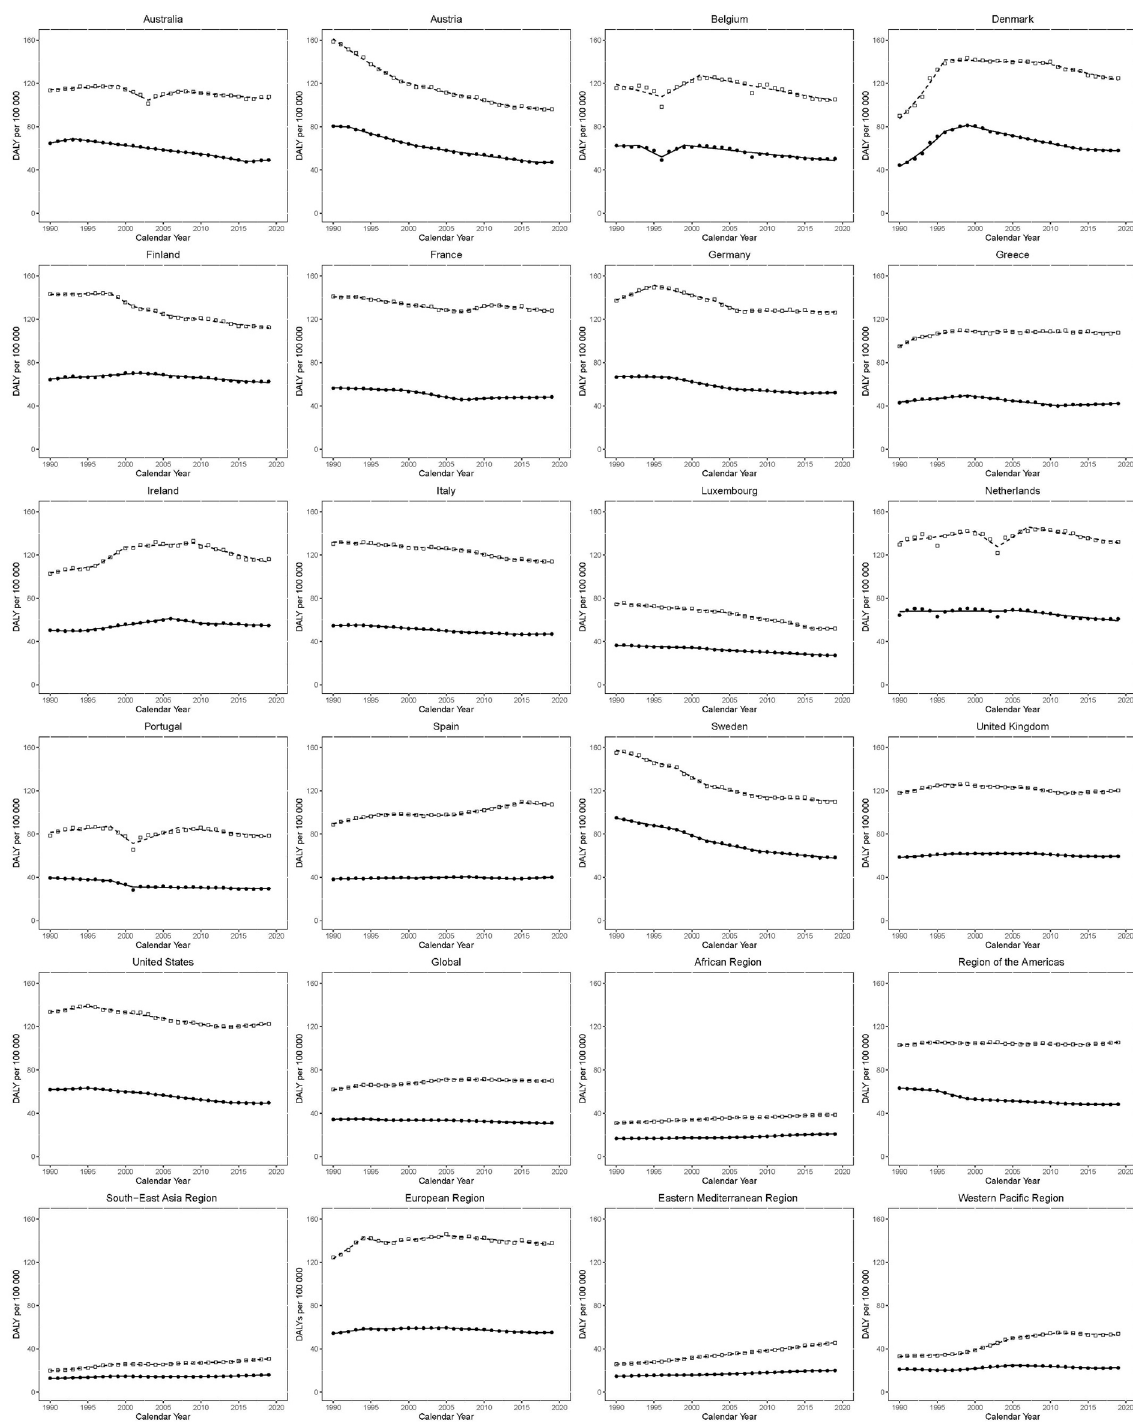
Figure 5. Trends in disability-adjusted life years (DALYs) per 100,000 for KC in EU15 + countries and WHO regions between 1990 and 2019. Open squares indicate males; and filled circles,